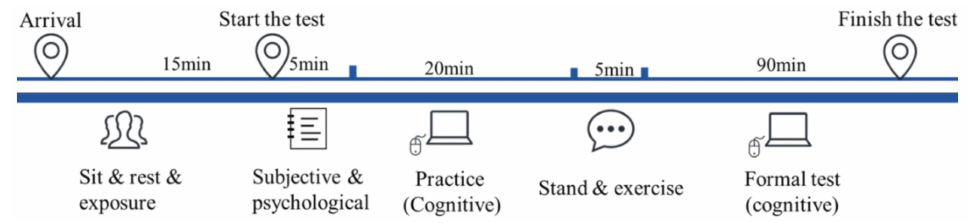
Figure 4. The program of artificial environment